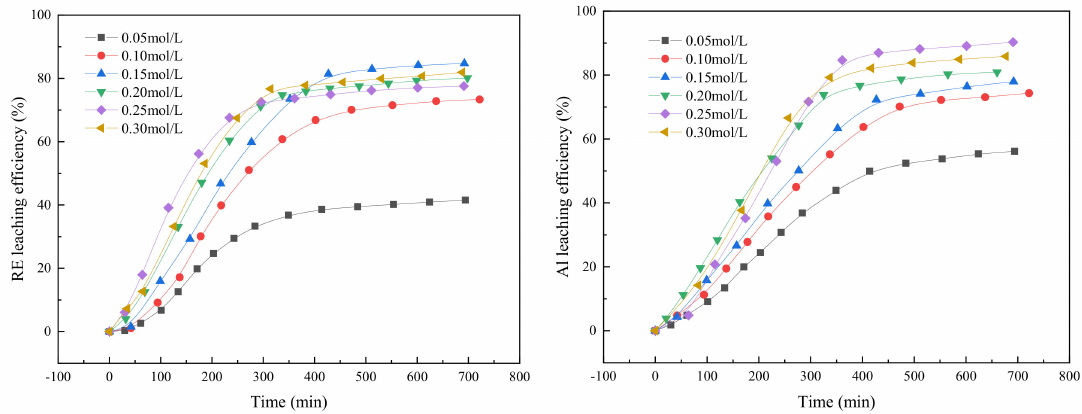
Figure 6. E ff ects of ammonium concentrations on the leaching rates of RE and